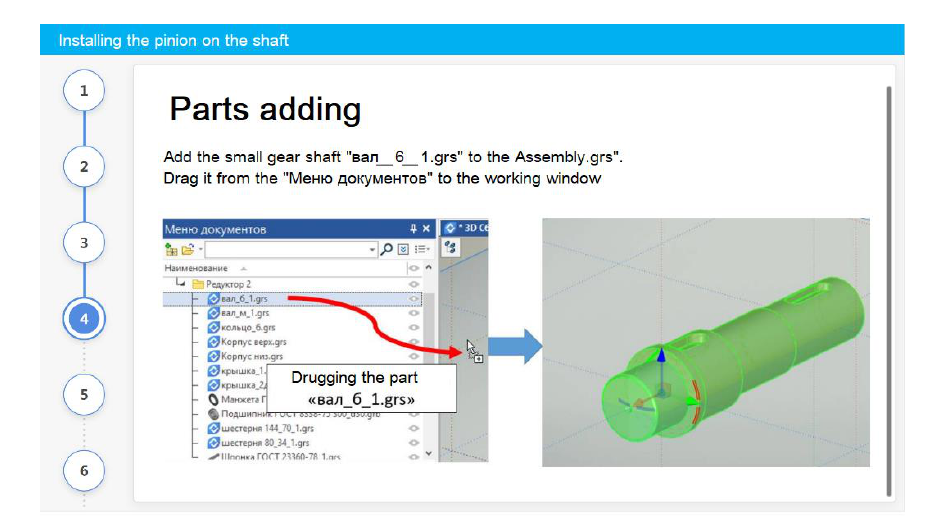
Fig. 13. Typical algorithm for adding a part to an assembly.